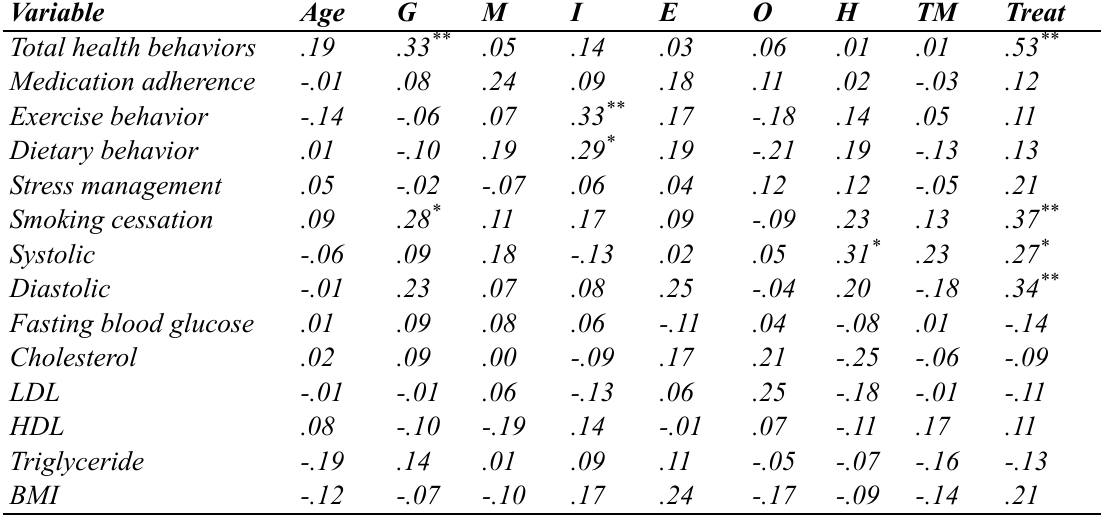
Table 6 Correlation (r) between health behaviors, clinical outcomes, and selected variable among MI patients Variable Age G M I E O H TM Treat Total health behaviors .19 .33 ** .05 .14 .03 .06 .01 .01 .53 ** Medication adherence -.01 .08 .24 .09 .18 .11 .02 .12 Exercise behavior -.14 -.06 .07 .33 ** .11 Dietary behavior .01 -.10 .19 .29 * Stress management .05 -.02 Smoking cessation .09 .28 * Systolic -.06 Diastolic -.01 Fasting blood glucose .01 .09 Cholesterol .02 .09 .00 LDL -.01 -.01 .06 -.13 HDL .08 -.10 .11 Triglyceride -.19 .14 .01 .09 BMI -.12 -.07